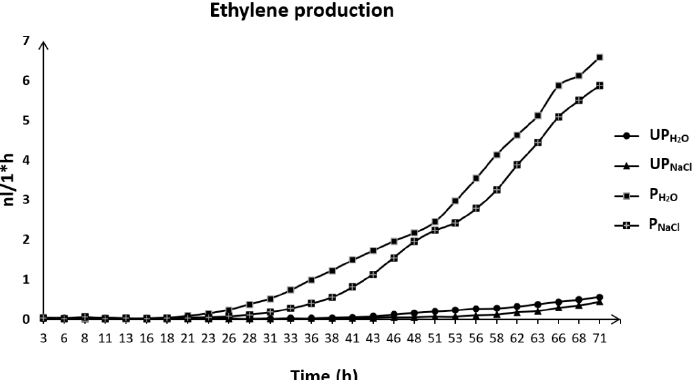
Figure 5. Ethylene production during germination of primed and unprimed seeds of Brassica napus in water and in NaCl (primed seeds germinating in water, P H 2 O ; unprimed seeds germinating in water, UP H 2 O ; primed seeds germinating in NaCl, P NaCl ; unprimed seeds germinating in NaCl, UP NaCl ). Analysis were conducted in three independent experiments ( n = 3).